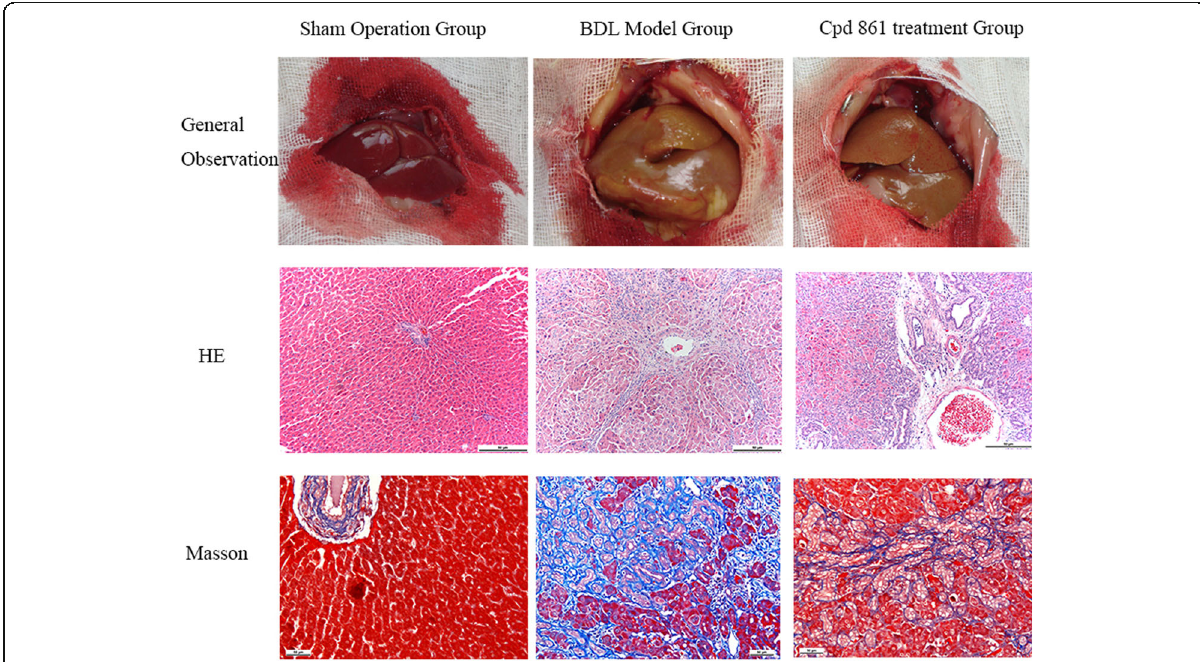
Fig. 1 Gross specimen morphology for sham operation, bile duct ligation, and Cpd861 groups. Histologic examination of liver sections was performed using H&E and Masson ’ s trichrome staining (magnification,